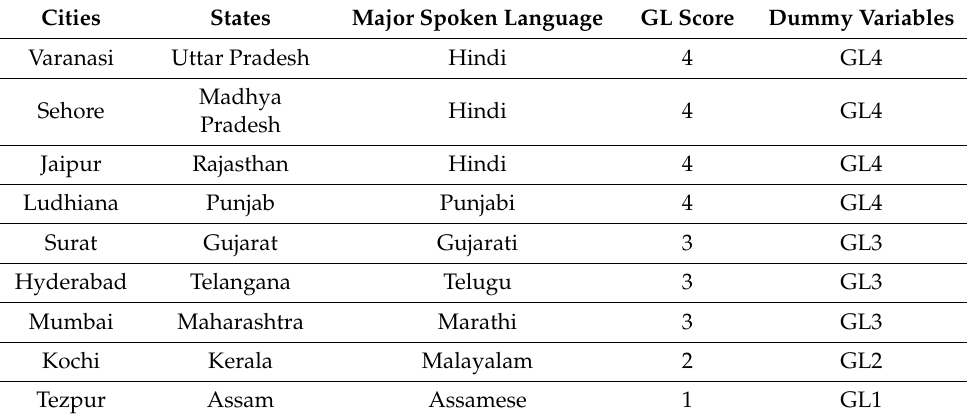
Table 1. Construction of the GL (gender-in-languages) variable. Cities States Major Spoken Language GL Score Dummy